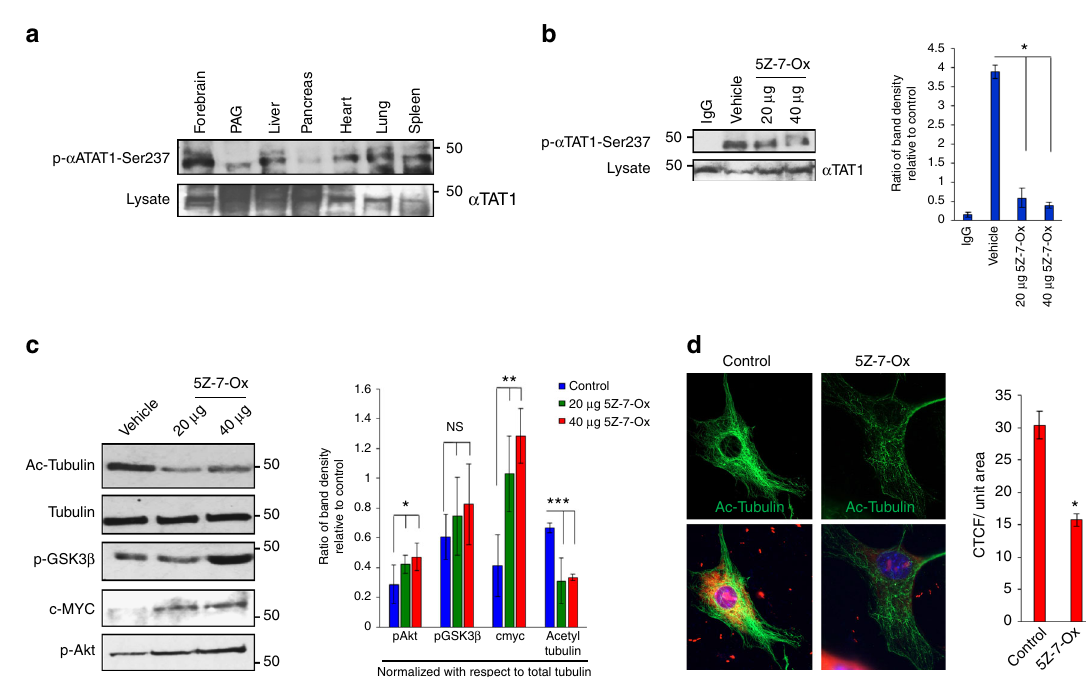
Fig. 7 TAK1-dependent α TAT1 activity in the brain. a Western blot analyses demonstrating phosphorylation levels on serine-237 residue of α TAT1 in lysates extracted from mouse tissues such as forebrain, periaqueductal gray (PAG), liver, pancreas, heart, lung, and spleen. b Representative western blottings demonstrating phospho- α TAT1-Ser237 and total α TAT1 levels in lysates extracted from mice ( n = 4) with and without treatment with TAK1 inhibitor 5Z-7-oxozeaenol (20 µ g or 40 µ g per animal; 1 h). Band density of four independent blots was calculated using ImageJ. Error bars represent SEM and type 2 t -test analysis show relative to control: * p < 0.05. c Representative western blottings demonstrating acetyl tubulin, total tubulin, pGSK3 β , cMYC, and pAKT-S473 levels in lysates extracted from mice ( n = 4) with and without treatment with TAK1 inhibitor 5Z-7-oxozeaenol (20 µ g or 40 µ g per animal; 1 h). Band density of four independent blots was calculated using ImageJ. Error bars represent SEM and type 2 t -test analysis show relative to control: * p < 0.05 (pAKT), ** p < 0.05 (cMYC), *** p < 0.05 (acetyl tubulin), NS is not statistically signi fi cant (pGSK3 β ). d Immuno fl uorescence images demonstrating acetyl tubulin (green) levels in neurons (red, Nissl stain) extracted from the dorsal root ganglia (DRG) of mice. The neurons were subjected to TAK1 inhibitor 5Z-7-oxozeaenol (20 µ M; 1 h), 24 h post dissection. CTCF per unit area was quanti fi ed using Image J, at least 40 cells were quanti fi ed per condition. Error bars represent SEM and type 2 t -test analysis show relative to control: * p <